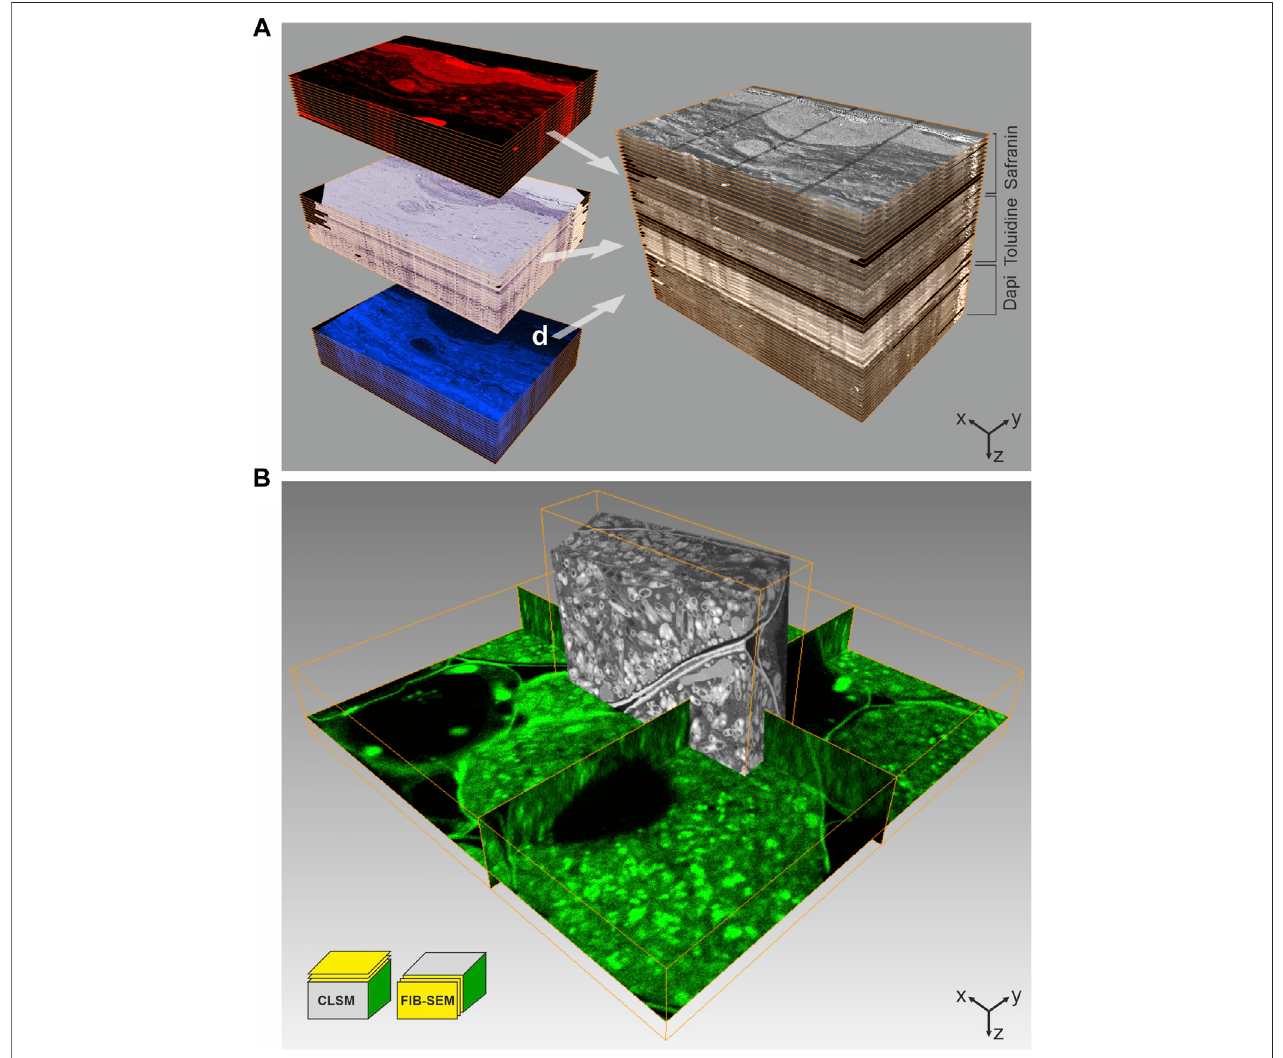
FIGURE 2 | CLEM using IRF samples. (A) Array tomography. 100 nm thick serial sections of a human skin biopsy, high-pressure frozen, freeze-substituted with uranyl acetate, osmium tetroxide and Safranin O, and embedded in HM20 were mounted on ITO-coated glass coverslips. This approach allows multiple on-section labelingtocomplementIRF.Thetopsubsetwasimagedby fl uorescenceLMwithoutfurtherstaining,usingtheSafraninOsignalintroducedduringFS,themiddlesubset showson-sectionstainingwithToluidine,andthesubsetofsectionswasstainedwithDapi.FollowingLM,allsectionswereimagedbySEMat2 kVusingin-lensSE detection. Combination of all images yields a volume that comprises multiple levels of information, ideal for in-depth characterization of complex biological structures. Volume size (x-y-z): LM stack: 321.0 × 221.5 × 5.1 μm³, SEM stack: 226.4 × 170.0 × 5.1 μm³. (B) 3D CLEM of root nodule from mung bean ( Vigna radiata ), colonized withnitrogen- fi xingbacteria( B.japonicum ).200 μmthicksectionswerehigh-pressurefrozenafterdegassingin1-hexadecene,followedbyFSandembeddinginHM20. The FS-medium contained uranyl acetate,osmium tetroxide and Acridine orange for fl uorescent labelingofthe bacteria.En bloc CLSM was performed toidentify a ROI, which was subsequently targeted by FIB-SEM. The CLSM and FIB-SEM volumes were merged using the Amira software package. The imaging plane of FIB-SEM is perpendicular to that of CLSM. Volume size (x-y-z): CLSM 57.2 × 57.2 × 9.0 μm³, FIB-SEM 21.8 × 6.2 × 15.9 μm³. Figure adapted from Lucas et al. (2012) with permission of Elsevier